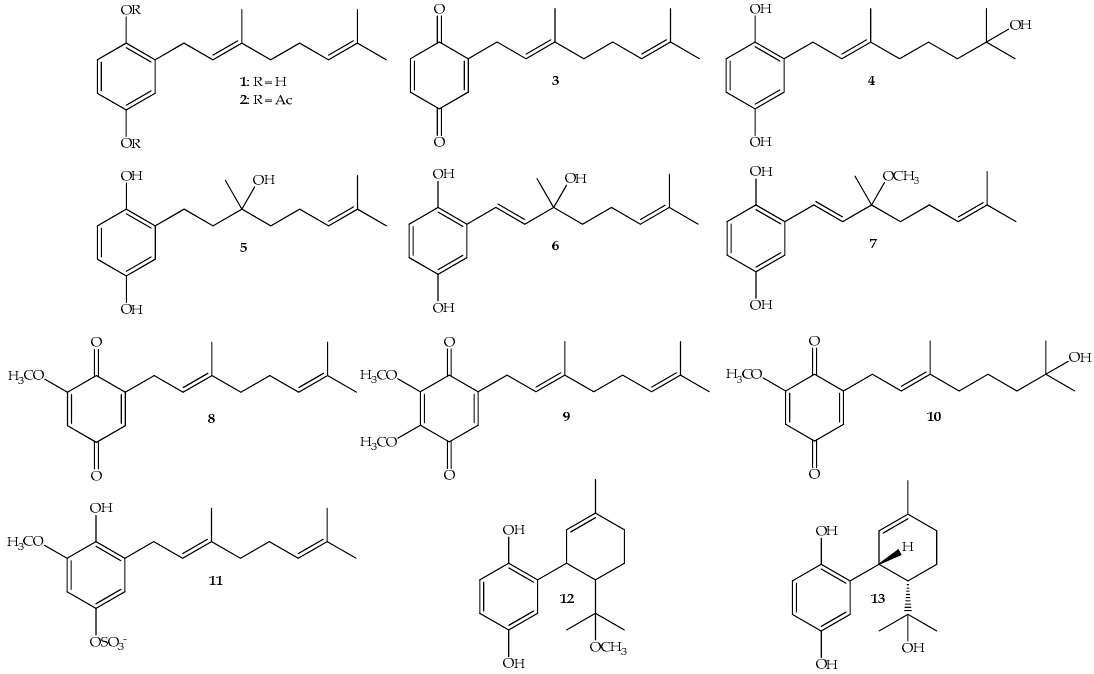
Figure 1. Structure of some naturally-occurring linear geranylated hydroquinones/quinones 1 – 11, and cyclodiprenyl meroterpenes 12 – 13 .